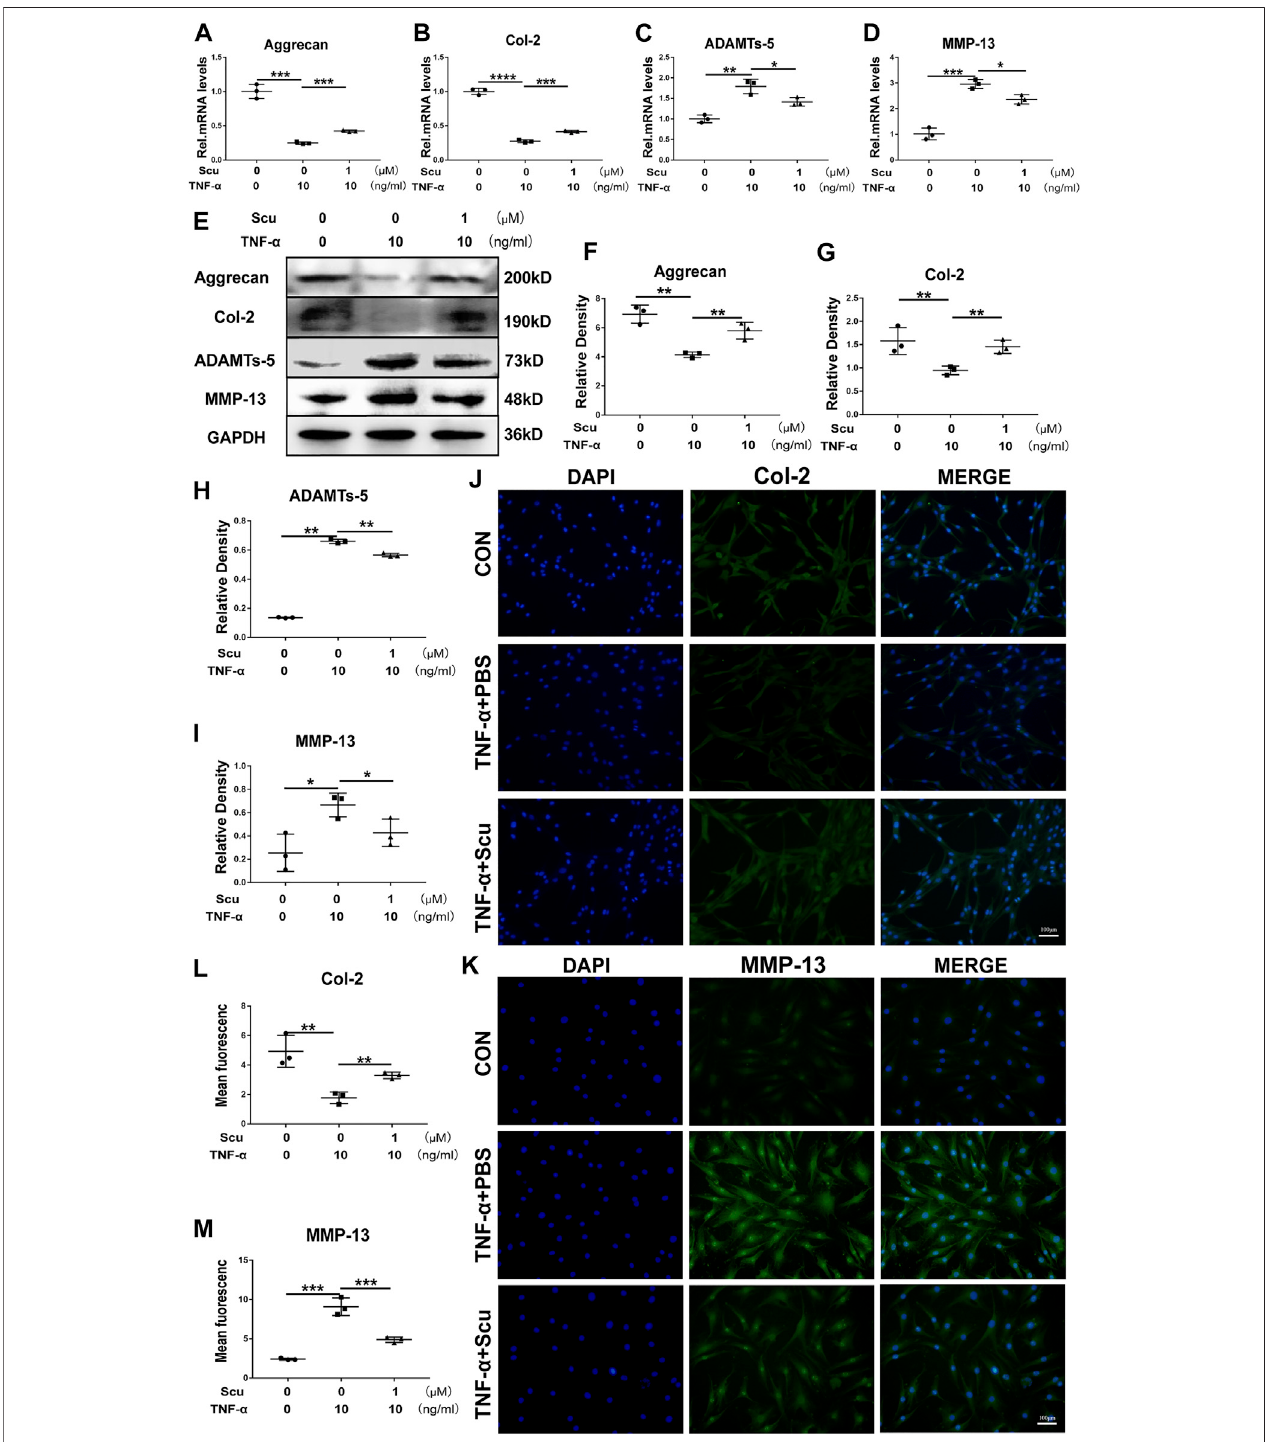
FIGURE2| Scutellarin retained cellmetabolismand alleviated degenerationofprimary HNPCs. (A – D) HNPCs were treatedwithor withoutTNF- α (10 ng/ml) inthe absence or presence of scutellarin (1 μ M) for 24 h. Then, total RNA from each group was extracted, and the transcriptional expression of Aggrecan, Col-2, ADAMTS-5, and MMP-13 was measured by real-time PCR. (E – I) HNPCs were cultured with PBS, TNF- α (10 ng/ml), TNF- α (10 ng/ml) +scutellarin (1 μ M) for 48 h. The protein expression levels of Aggrecan, Col-2, ADAMTS-5, and MMP-13 were assayed by Western blotting. (J – M) After culturing as indicated for 48 h, immuno fl uorescence staining was performed to examine the protein levels of Col-2 and MMP-13 (scale bar: 100 μ m). Each experiment was performed three times independently. (* p < 0.05, ** p < 0.01, *** p < 0.001).